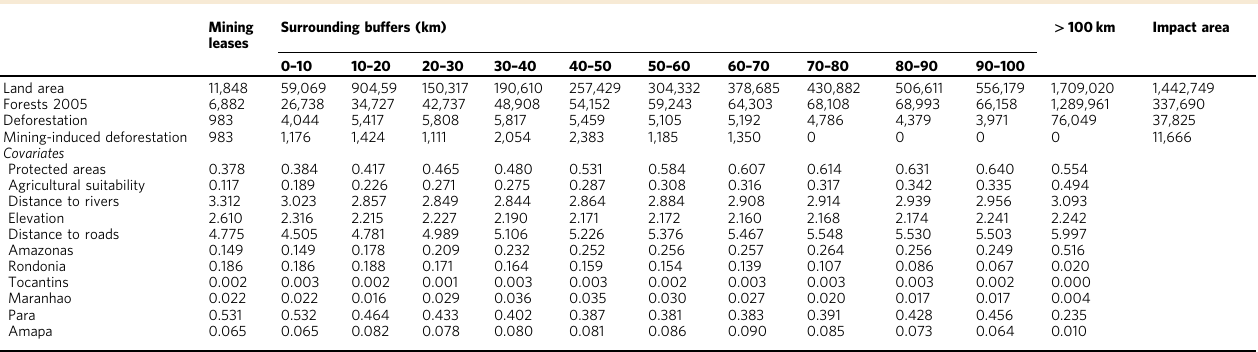
Table 3 Summary statistics for mining leases, surrounding buffers, unmatched controls farther than > 100 km from mining leases, and the total impact area